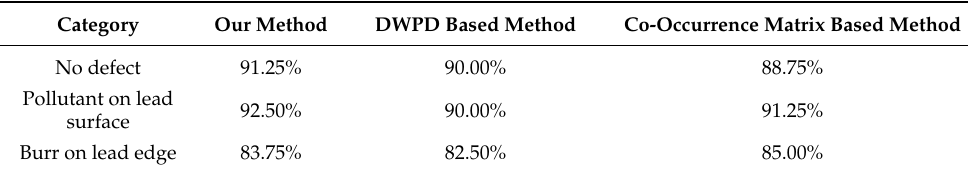
Table 2. Classification accuracy for lead defect detection.